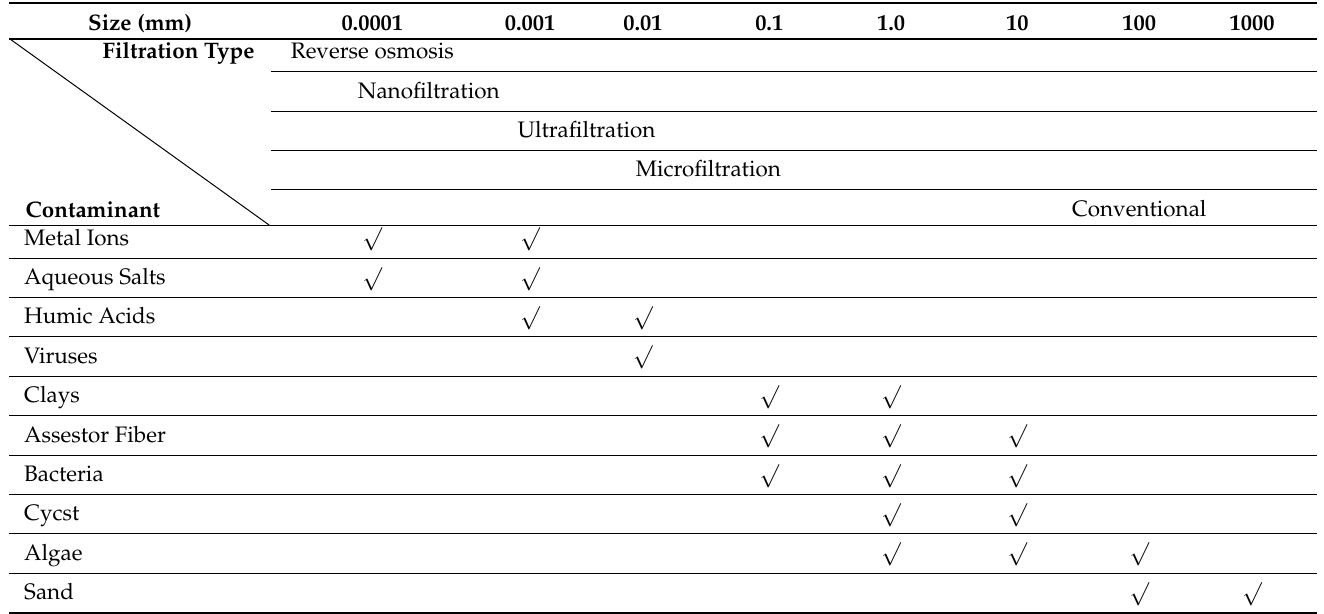
Table 1. Contaminant with respective membrane filtration